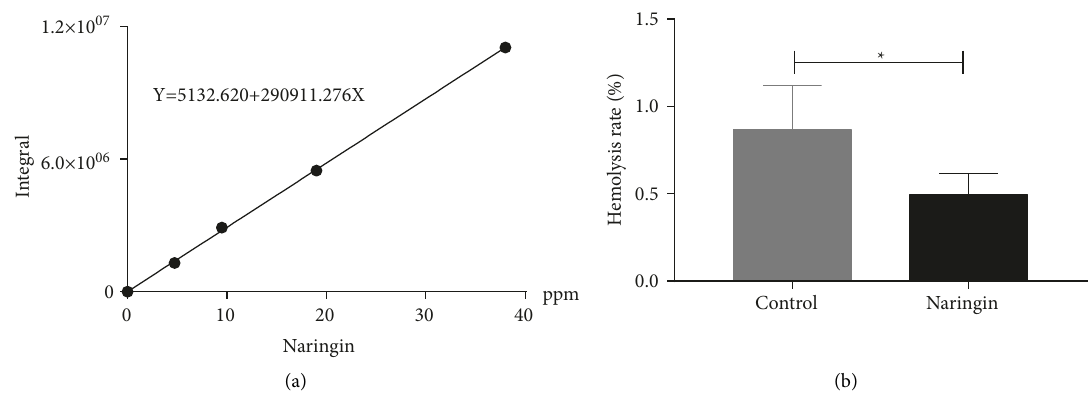
Figure 2: (a) Regression equation is Y � 5132.620 +290911.276X. The X -axis is naringin content with 4.75ppm, 9.5ppm, 19ppm, and 38ppm and Y -axis represents the corresponding chromatographic integral. (b) Hemolysis of packed RBCs at 35 days. ∗ signifies p < 0 . 05 vs control group.